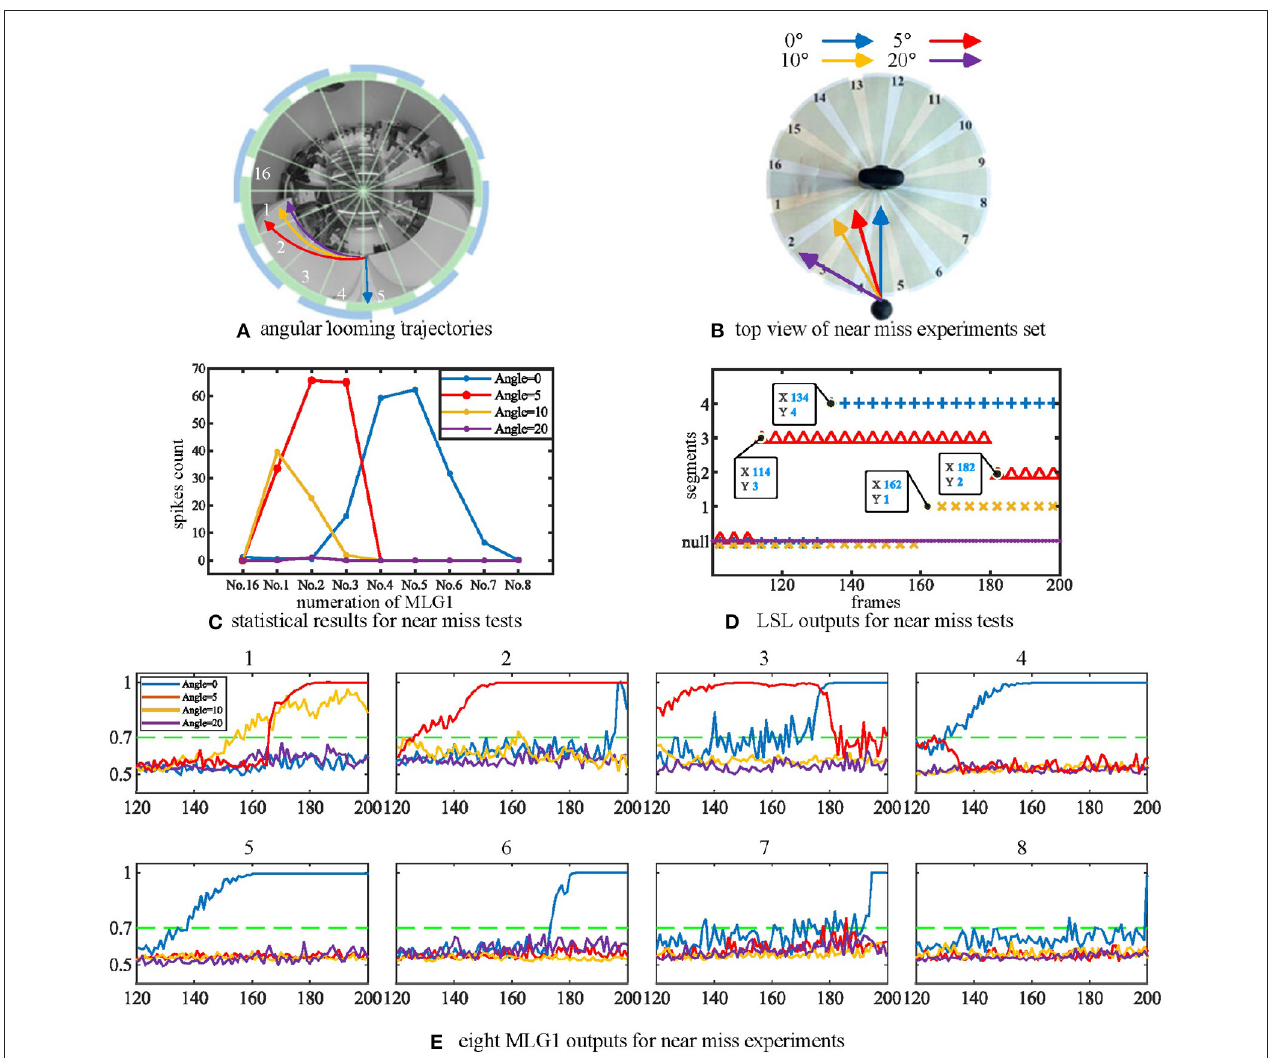
FIGURE 6 | (A) The angular looming experiments set. The blue, red, yellow and purple lines represent angular looming trajectories with angles 0, 5, 10, and 20 deg, respectively. Different approach angles make the images of the balls travel through various segments of the receptive fields of view. (B) Top view of the angular looming test. (C) statistical results for angular looming experiments. The Y-axis denotes the spike count. The X-axis shows the numeration of MLG1 neurons, which is the same as in Figure 3A . Different looming trajectories excite corresponding MLG1 neurons. However, as the looming angles increase, neuron reactions decrease. Each experiment is repeated ten times at each angle. (D) the outputs of LSL in each of four angular looming tests. (E) eight MLG1 outputs for angular looming experiments. The X-axis is the number of frames. The Y-axis donates a normalized membrane potential. It should be noted that the closest object has a significant distortion in the panoramic image, so that it will elicit responses by adjacent